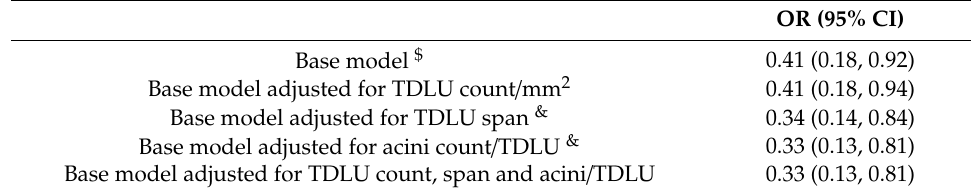
Table 4. Relationships between MD decline* and breast cancer-specific death before and after adjustment for TDLU measurements among ER-positive patients treated with